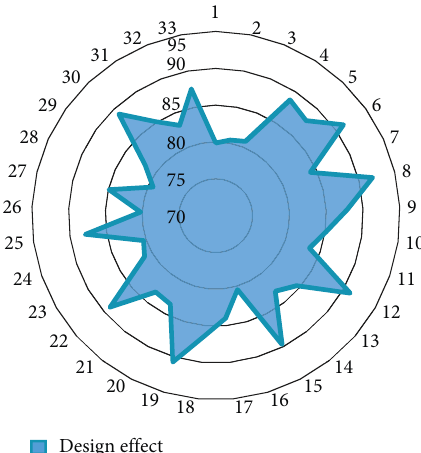
Figure 9: Evaluation of virtual product